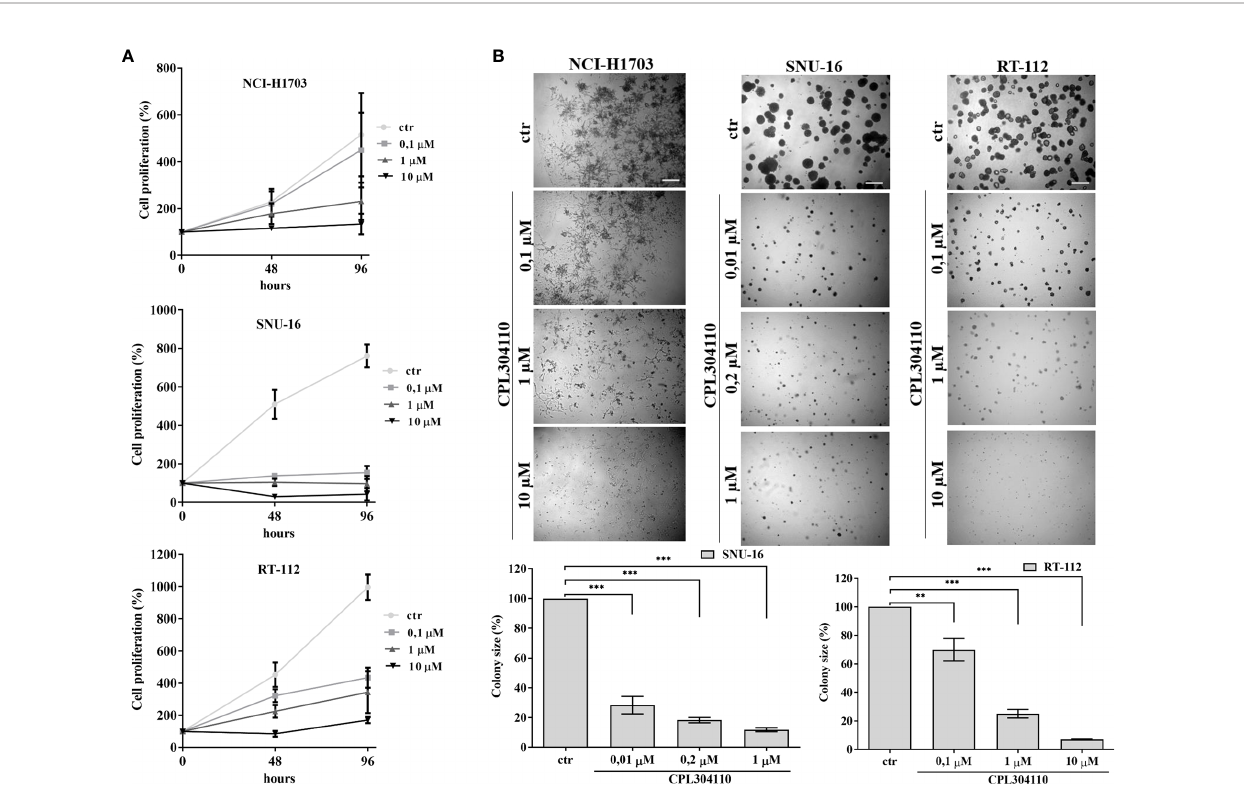
FIGURE 1 | Anti-proliferative effect of CPL304110. (A) NCI-H1703, SNU-16, and RT-112 were exposed to the indicated concentrations of the FGFR inhibitor, CPL304110, for 48 and 96 h followed by assessment of cell viability using the MTT assay. Data are expressed as mean ± SD, n = 3. (B) Cells were grown in 3D Matrigel ® for 14 days in the presence of CPL304110. Representative pictures were taken, colonies were measured and statistically analyzed with ImageJ. Scale bar represents 100 m m. Data are expressed as mean ± SD, **p ≤ 0.01, ***p ≤ 0.001, n =